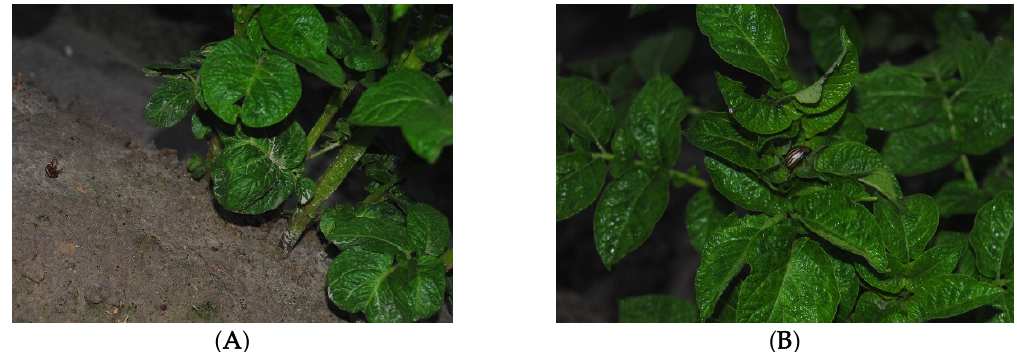
Figure 13. Yield after the research: ( A )—the row of potatoes sprayed with the dressing substance from the mobile machine, ( B )—the row of potatoes which was not sprayed with the dressing substance.